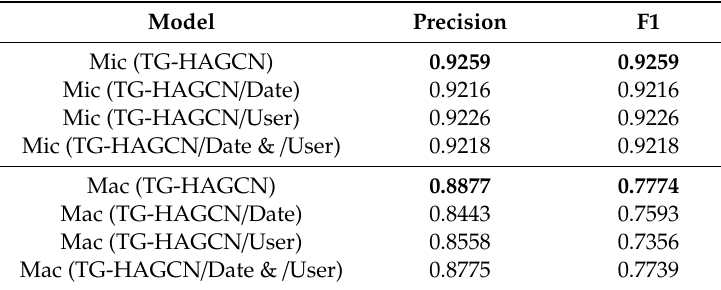
Table 8. Precision and F1 score of ablation study. “TG-HAGCN / Date” means that the date nodes are removed in the TG-HAGCN model and the input graph is only “user-post-word” graph. “TG-HAGCN / User” means to remove user nodes from TG-HAGCN model, that is, the input graphs are “post–word” graph and “date–word” graph. “TG-HAGCN / Date & / User” means that the input graph is only “post–word” graph.